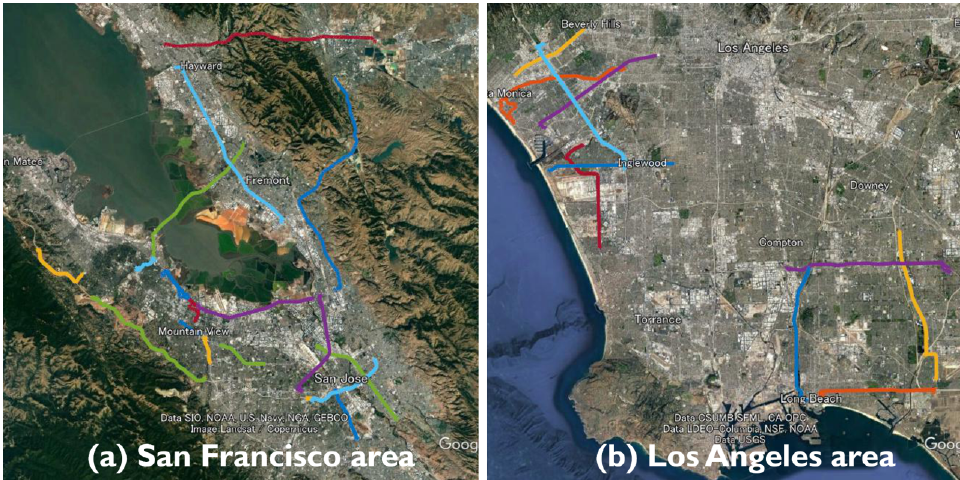
Figure 1. Driving trajectories included in test data provided at GSDC 2022. In total, 36 runs were provided and divided into two parts: one run in the San Francisco area and another in the Los Angeles